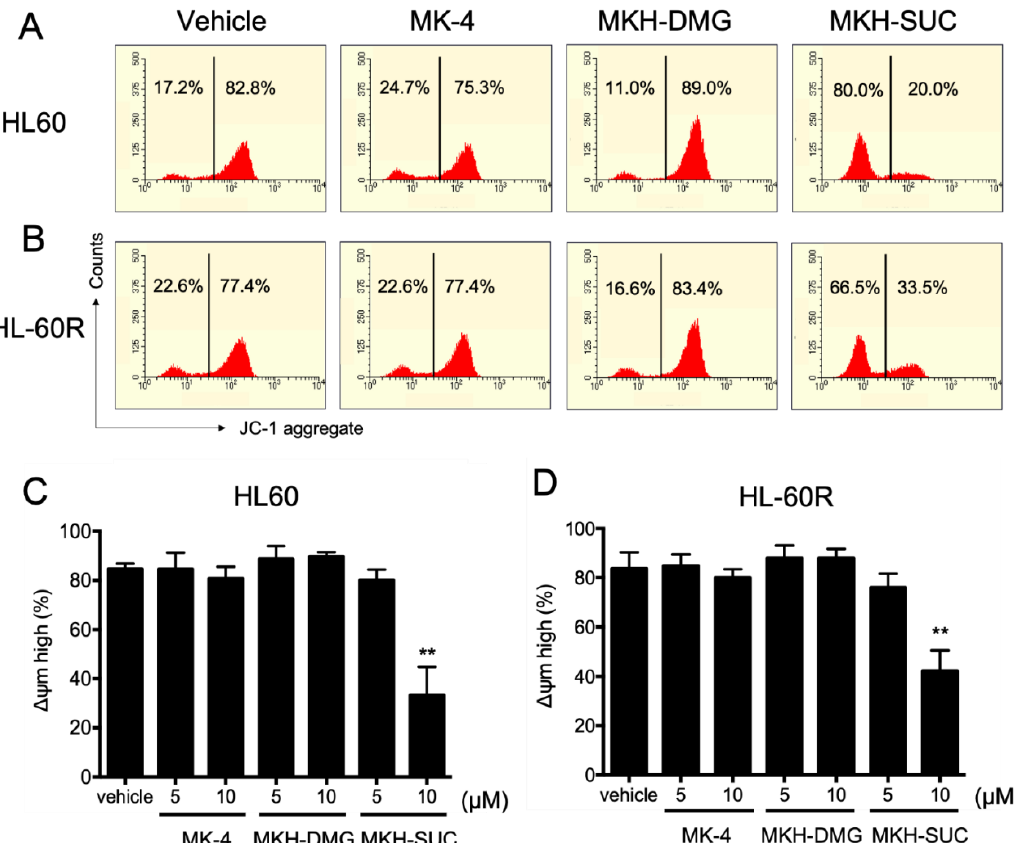
Figure 7. Effects of MK-4 and MKH derivatives on the mitochondrial membrane potentials of HL60 and HL-60R cells. Typical flow cytograms of HL60 ( A ) and HL-60R ( B ) cells treated with the test drugs at 10 µM for 48 h. Percentages of ΔΨm-high cells among HL60 ( C ) and HL-60R ( D ) cells treated with 5 or 10 μM MK-4, MKH-DMG, or MKH-SUC for 48 h. The mitochondrial membrane potentials were determined using flow cytometry after JC-1 staining. Data are shown as mean ± SD from triplicate experiments. ** p < 0.01 vs. vehicle by Dunnett’s test.